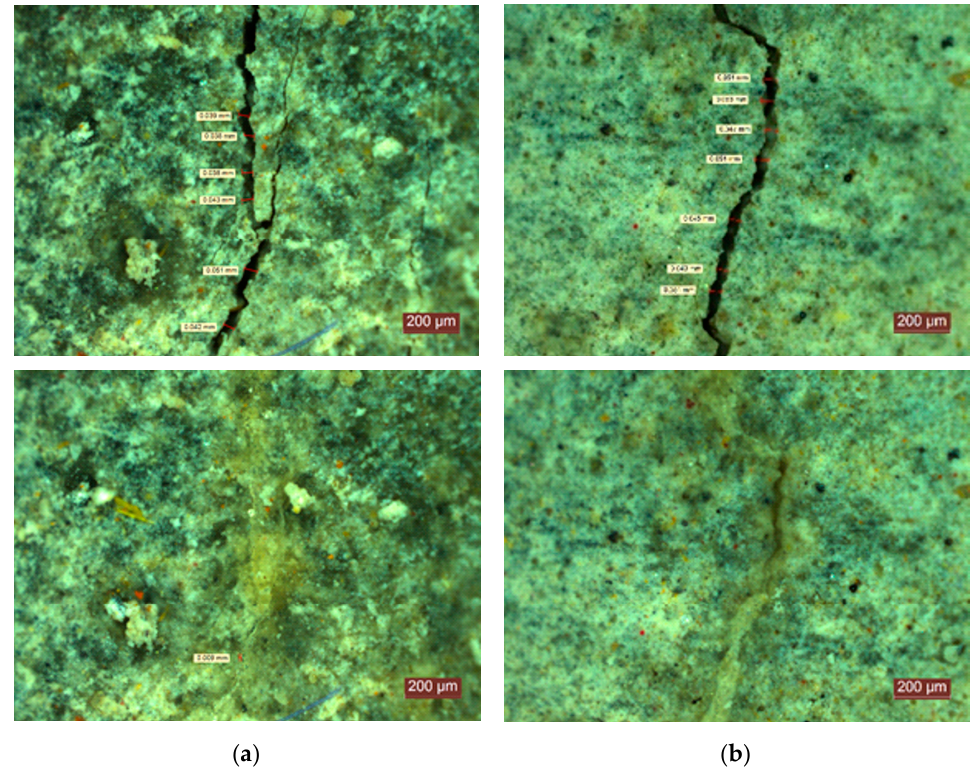
Figure 7. Initial crack and self-sealing products at 20 days for an ICW content of 3%: ( a ) T3r; ( b ) T3c.